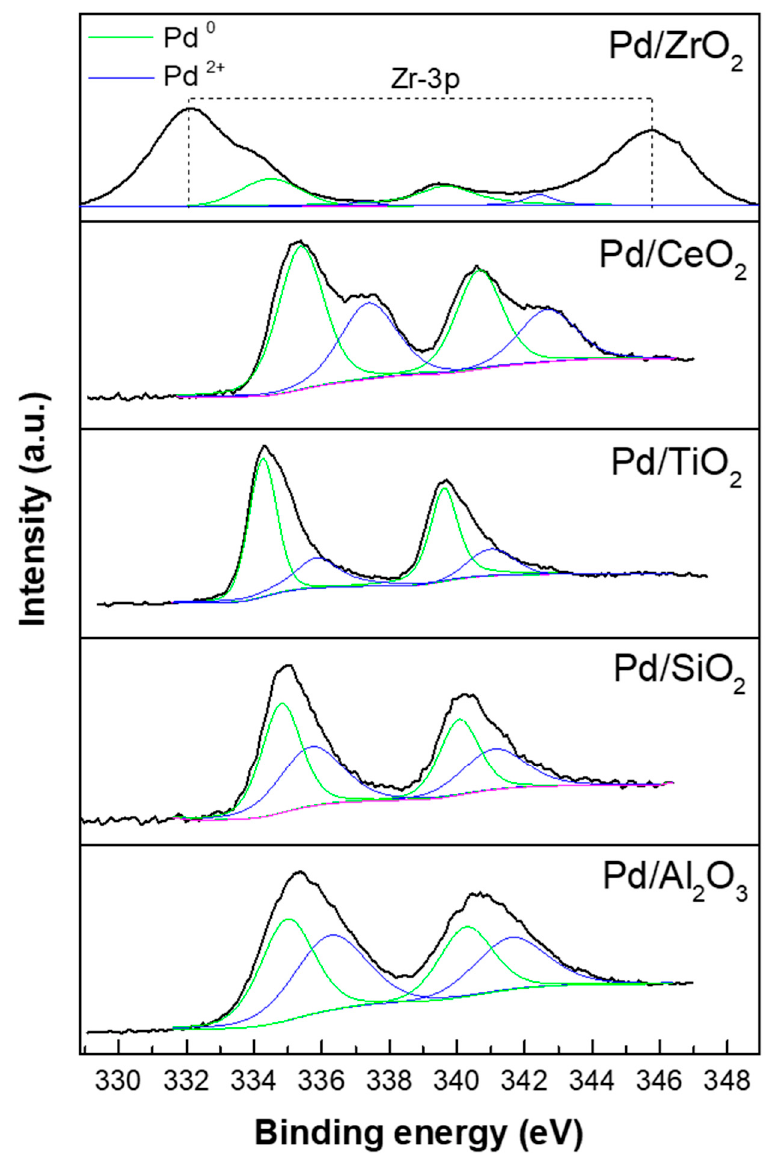
Figure 6. XPS spectra of Pd catalysts.